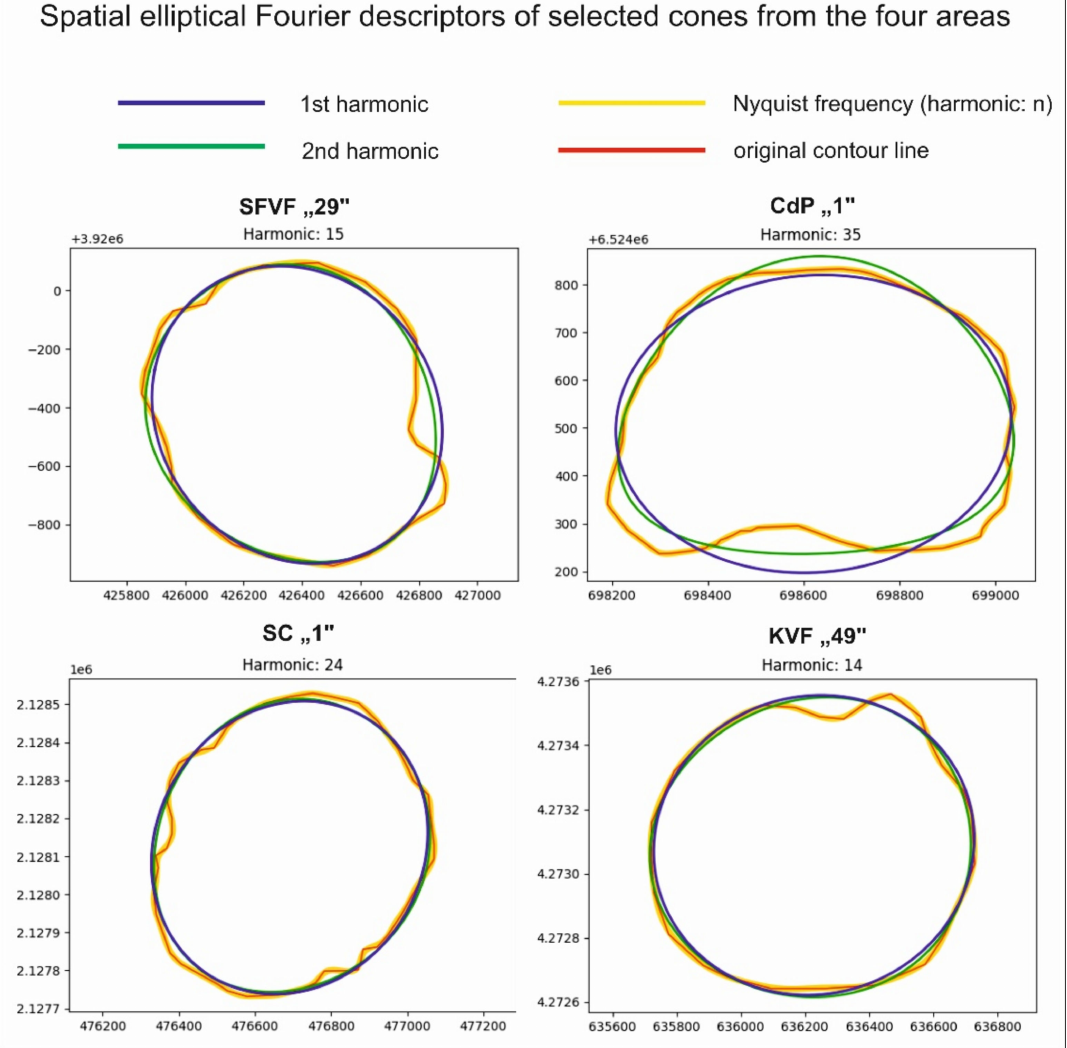
Figure 7. Spatial Elliptical Fourier Descriptors of four selected cones from each area. Blue represents first, green second harmonic, red is the original contour line, and yellow is the harmonic that corresponds to the Nyquist frequency of the shape ( N ). Note that there is no practical difference between the actual contour line and the last (maximum) harmonic; in other words, this latter curve is a very good approximation of the